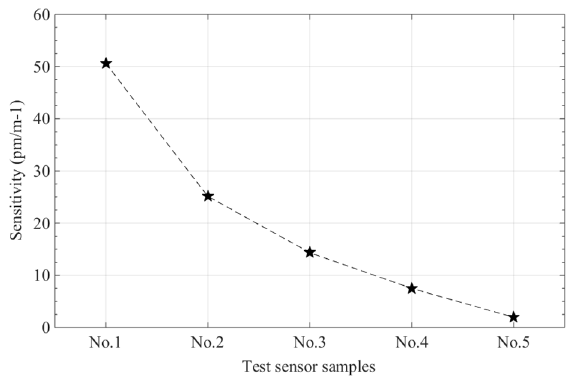
Figure 6. Sensitivity of fiber Bragg grating sensors at different embedded depths.